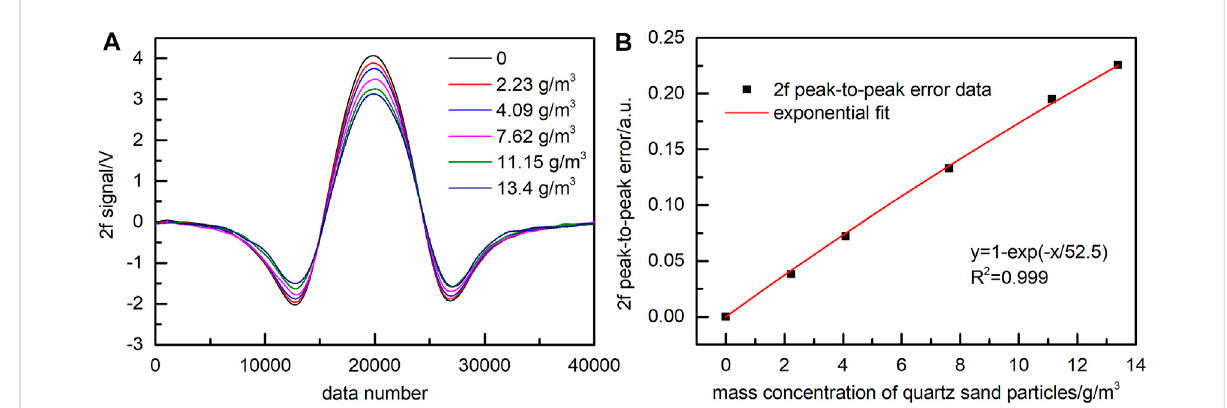
FIGURE 4 Effectofquartzsand(54 – 76 μ m)ontheNO2fsignal. (A) 2fsignalwithremovedbackground. (B) Exponential fi ttingfunctionof2fpeak-to-peak error.